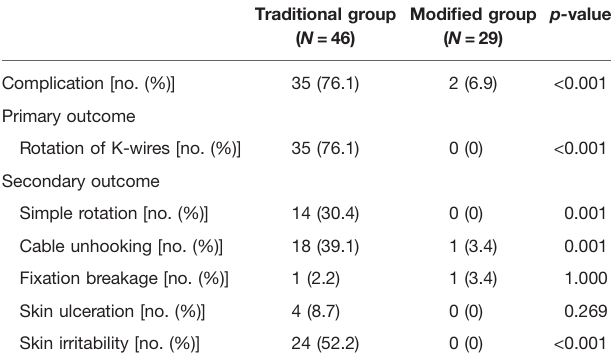
TABLE 3 | The primary outcome and secondary